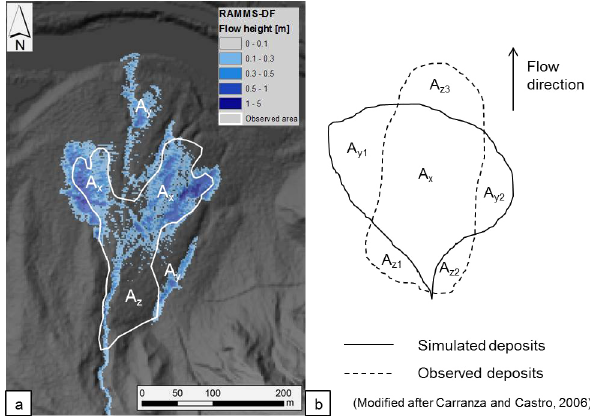
Figure 2. Superposition of the simulated area with the observed area of recently deposited debris-flow material at the Festeticgraben debris fan (a) . Sub-areas were derived through superimposing the simulated deposits and the observed deposits (b) and following the approach of Carranza and Castro (2006), we assessed our simula- tion results. Area A x represents the simulated deposits within the observed area, whereas A z indicates the non-simulated debris-flow deposits within the observed area. Simulated deposition outside the observed area is shown as A y